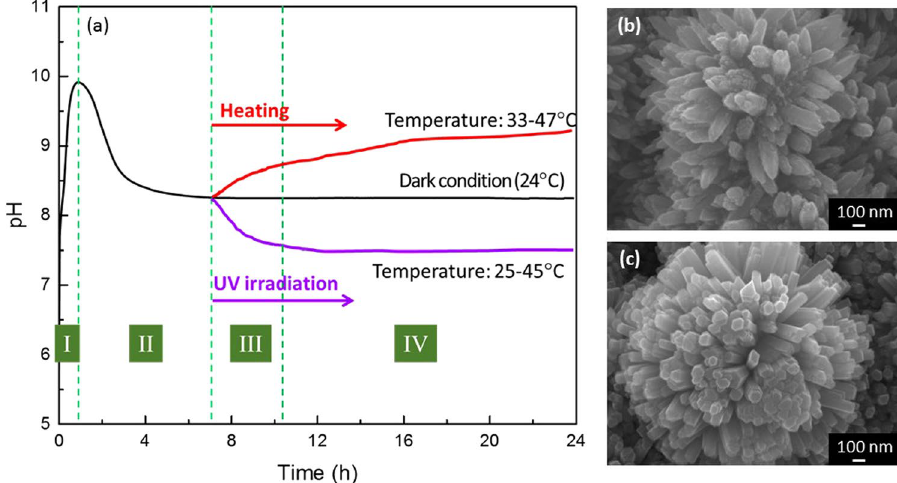
Figure 7. ( a ) Controlled experiment examining the pH change due to UV illumination or heating. ( b ) Morphology of the specimen after 7 h in dark conditions followed by 17 h of heating. ( c ) Morphology of the specimen after 7 h in dark conditions followed by 17 h under UV